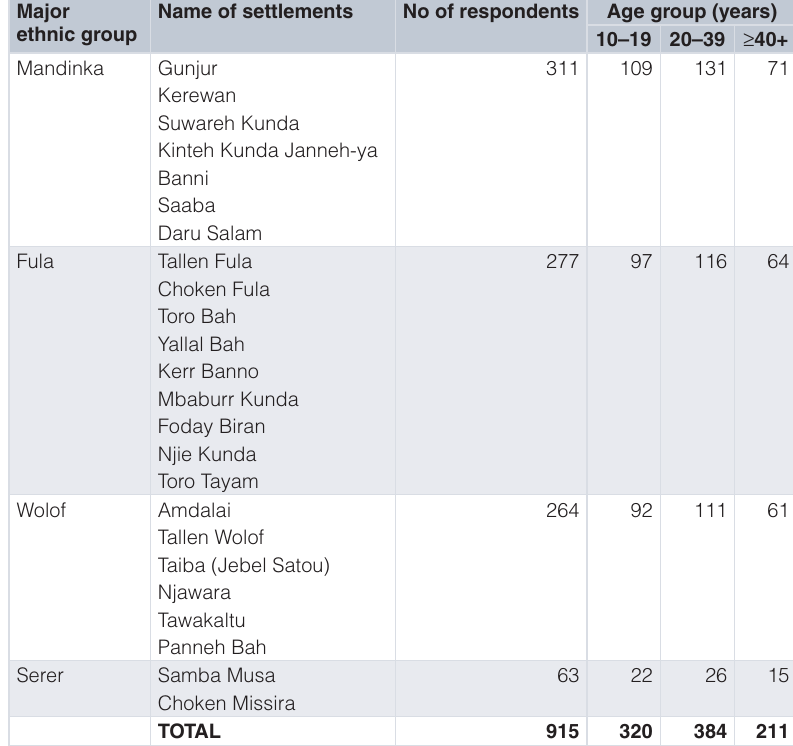
Table 2. Sample size determination by ethnic group, settlement, number of respondents and age group (in years). Major Name of ethnic group